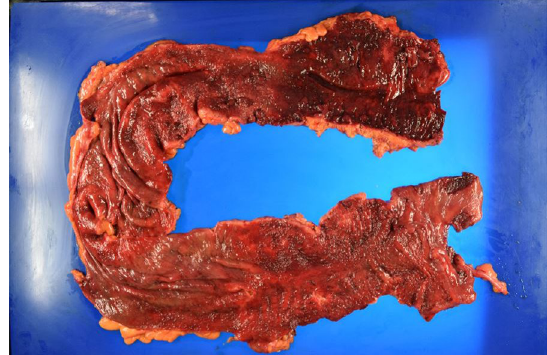
Fig. 5 Pathological findings: ulceration and disruption of the glandular ducts, and infiltration of inflammatory cells, mainly lymphocytes, in the intrinsic mucosal layer to the submucosal layer, with particularly severe inflammation of the superficial